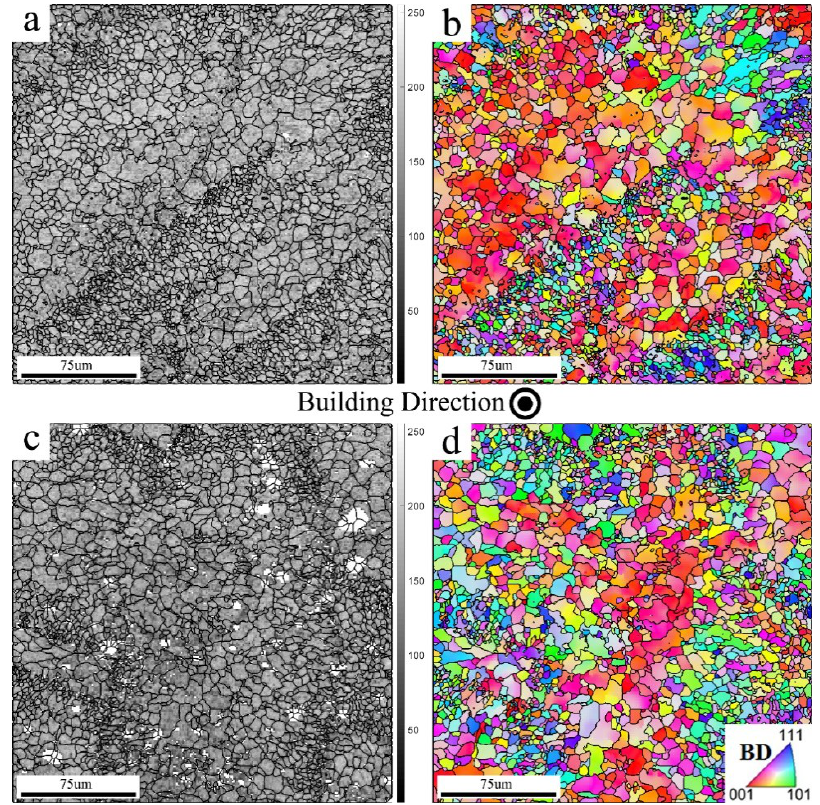
Figure 7. Building surfaces of ( a,b ) CL and ( c,d ) EOS manufactured AlSi10Mg SLM vertical samples, indicating ( a , c ) band contrast (BC) and ( b , d ) inverse pole figure (IPF) maps, respectively. In ( d ), an inset color-coded key triangle indicates the crystallographic orientations.